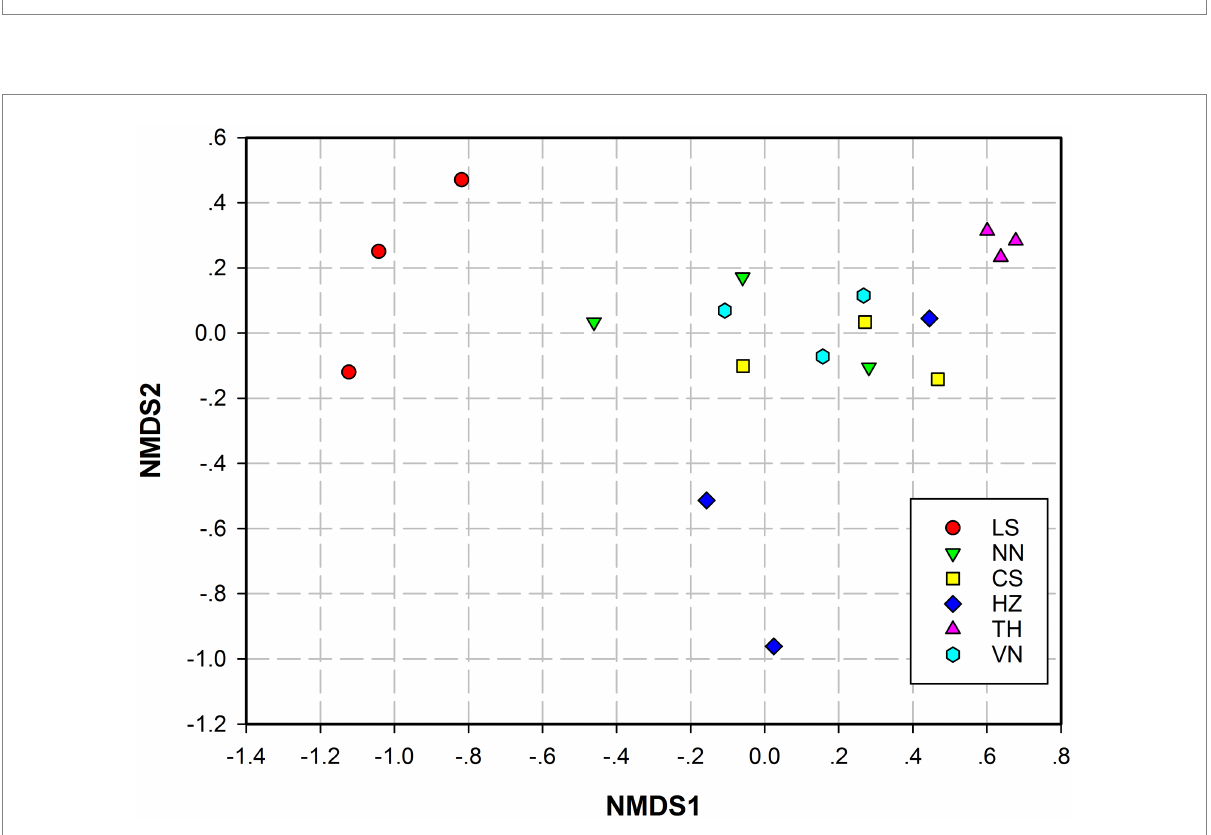
FIGURE 4 Nonmetric multidimensional scaling (NMDS) analysis of the bacterial communities in different C. medinalis geographic populations. NMDS plots were constructed using Bray–Curtis. Stress values (stress = 0.079) indicate a good